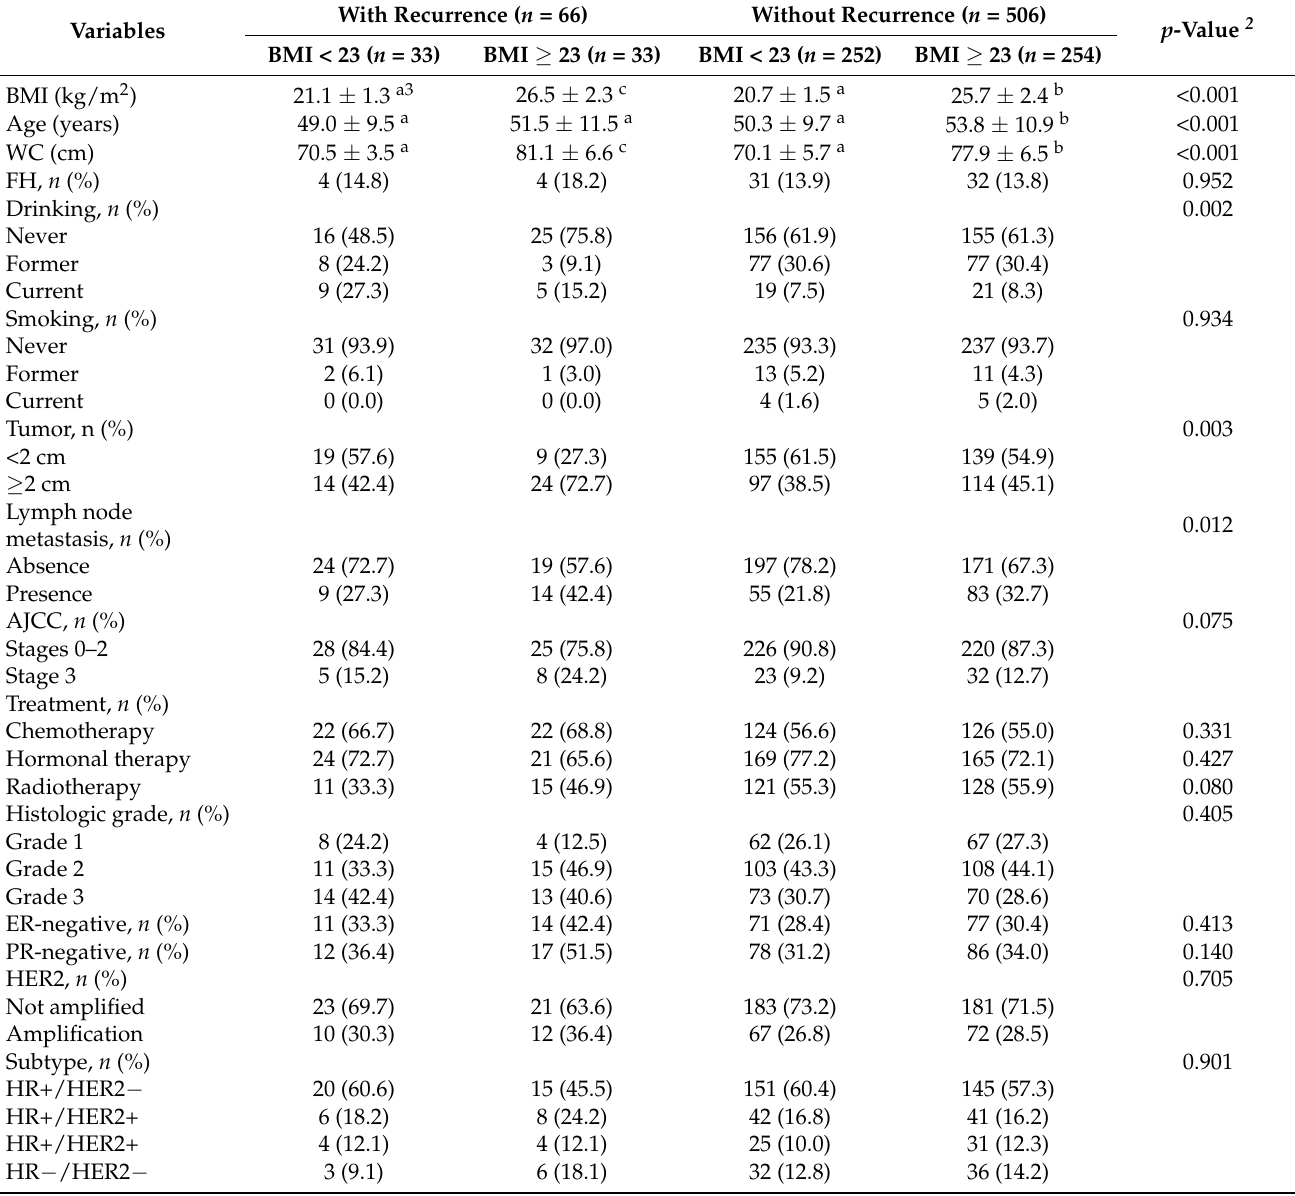
Table 1. Characteristics of breast cancer patients with and without cancer recurrence.